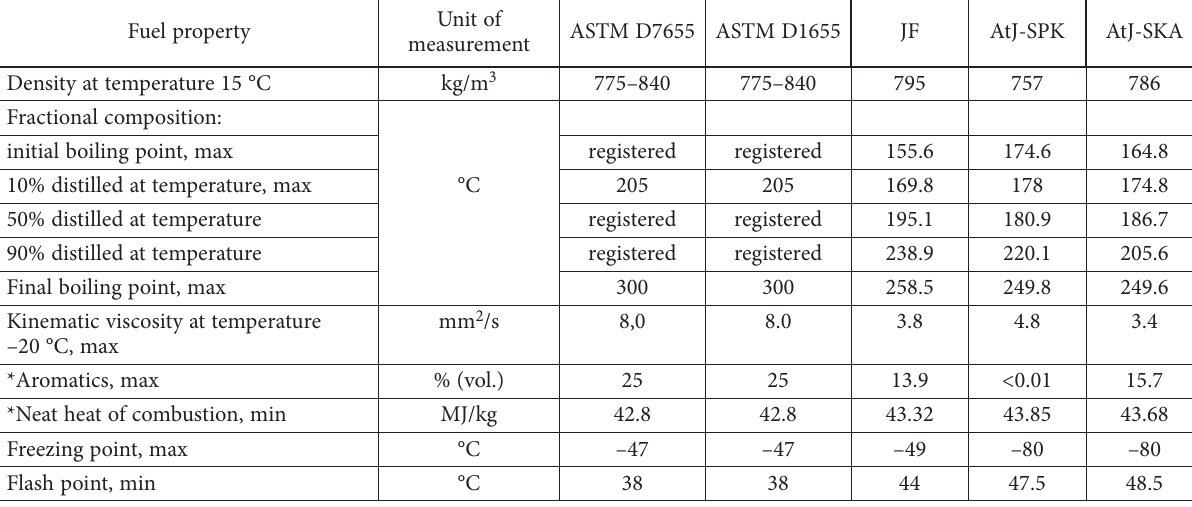
Table 4. Comparative characteristics of studied fuel samples and standard requirements (source: author development) Fuel property